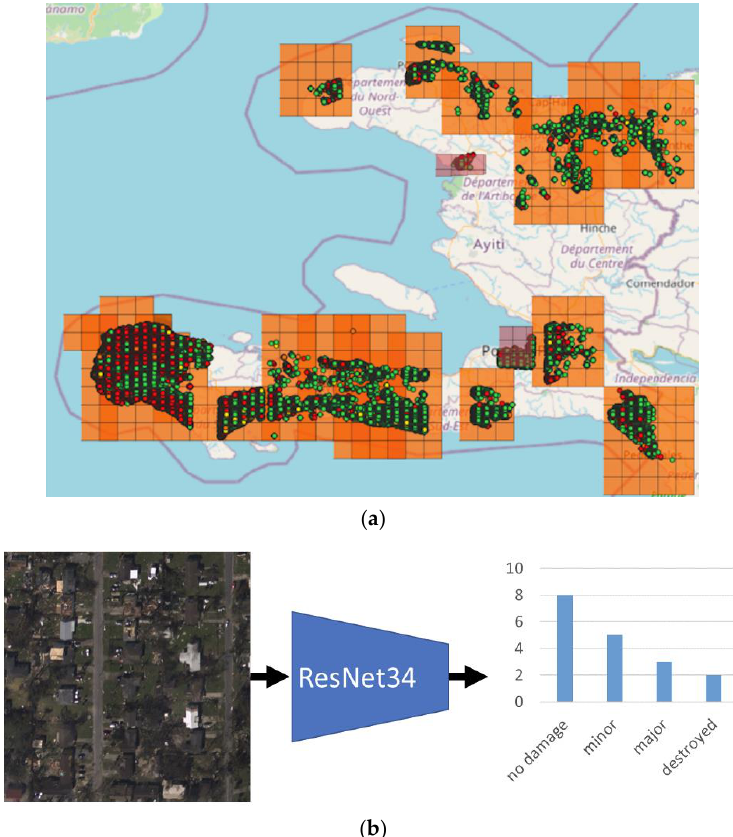
Figure 2. ( a ) Imagery extents (colored squares) and predicted building damage locations (colored points) for Haiti after Hurricane Matthew. This feature was fed into the model and was generated by using deep learning on visible spectrum satellite imagery. ( b ) Region-level building damage estimation model overview.